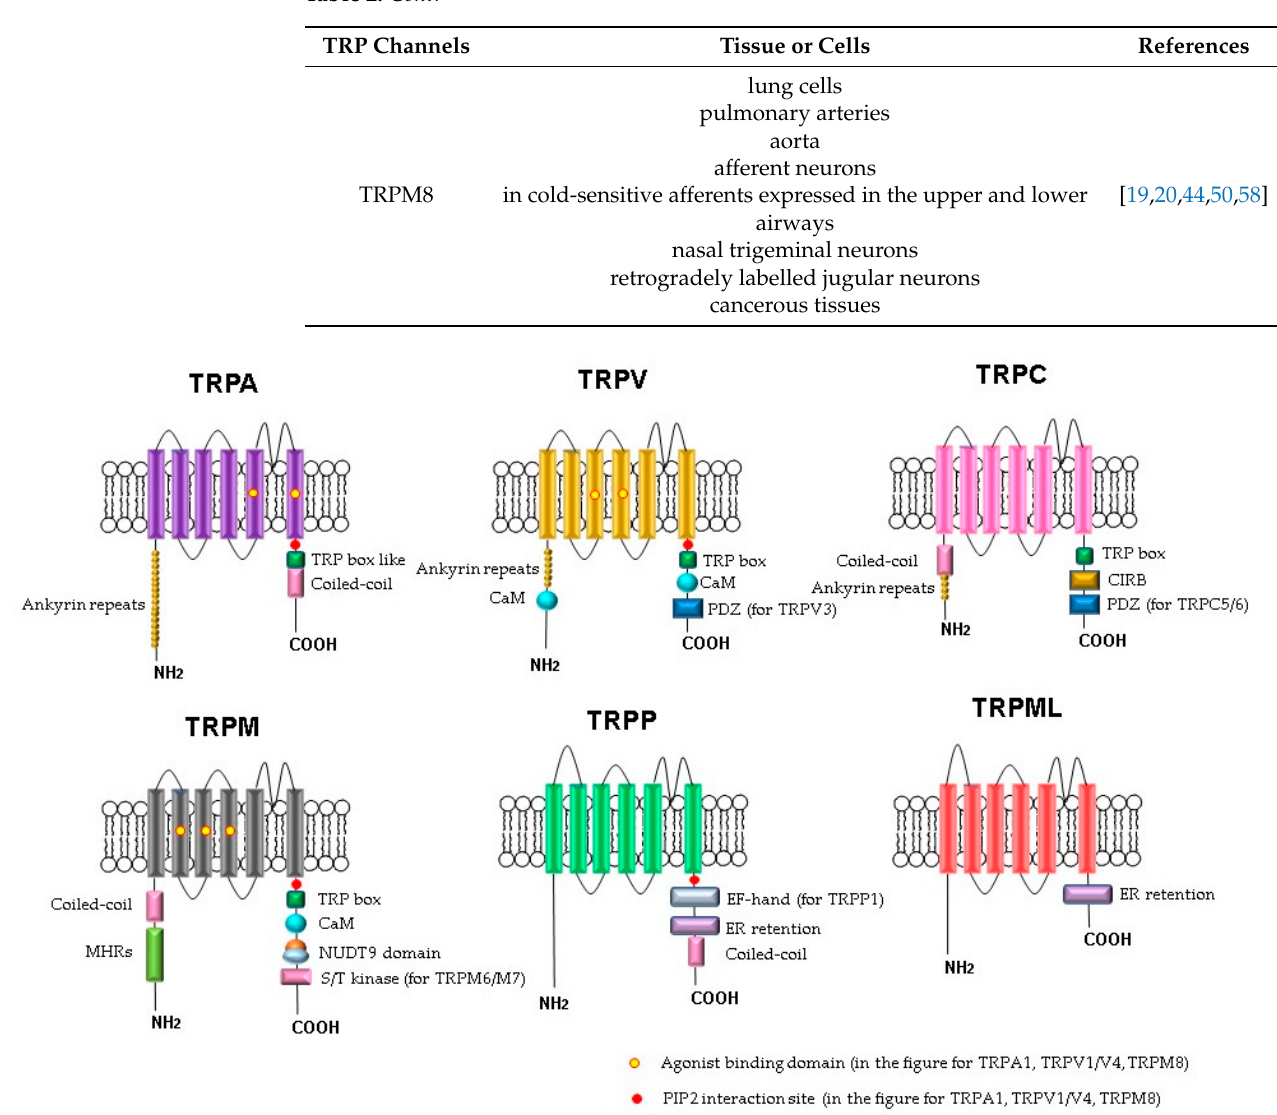
Figure 1. Schematic structure of TRP channels. Monomers of TRP channels consist of six transmembrane segments and a pore-forming return loop between S5 and S6. The intracellular N- and C-termini are distinguished in the length and domains. The TRP box is similar for TRPC, TRPV, TRPM, and a TRP box-like region for the TRPA1 channel. Coiled-coil domains (CC) are located in the C-terminus of TRPA and in the N-terminus of TRPC and TRPM. TRPM share melastatine high homology regions in their N-terminus, (MHRs). The TRPC subfamily of TRP channels has binding domains for calmodulin (CaM), inositol triphosphate receptor binding site (CIRB), and the PDZ-binding specific motif (PDZ). Substrates of NUDT9 are the adenosine 5 ′ -diphosphoribose (ADPR) or the ADPR-2 ′ -phosphate (ADPRP). NUDT9 domain is specific for TRPM2. TRPM6 and TRPM7 contain a serine/threonine kinase domain (S/T kinase). TRPP1 presents a calcium-binding motif (EF-hand), while TRPP and TRPML exhibit an endoplasmic reticulum retention (ER retention) domain. TRP channels are modulated by phosphatidylinositol-4,5-bisphosphate